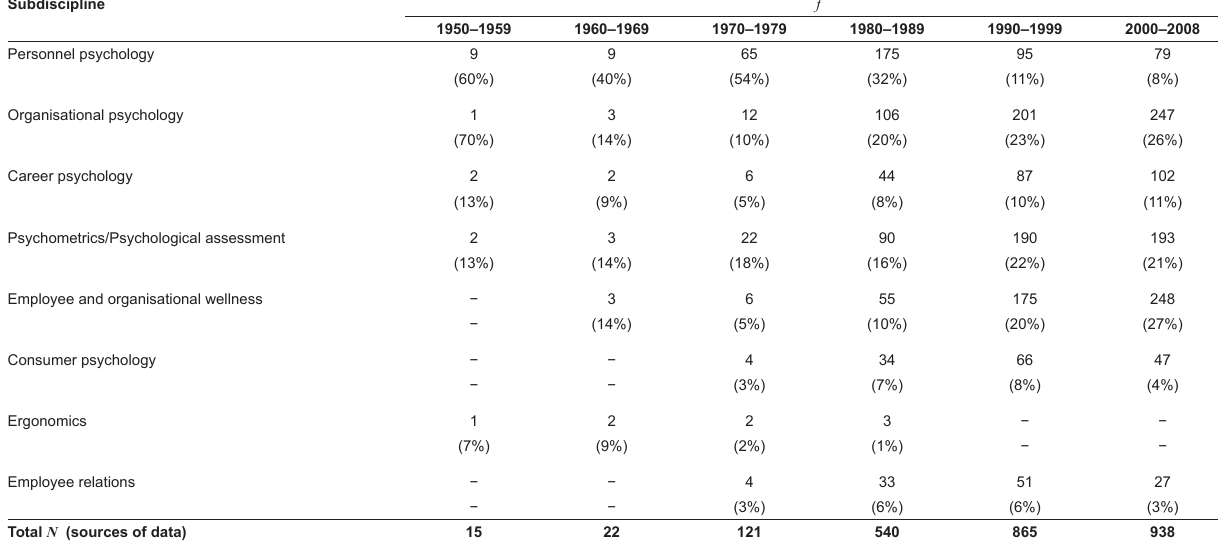
TABLE 2 Frequencies of dominant research in Industrial and organisational psychology subdisciplines: 1950–2008 ( N =